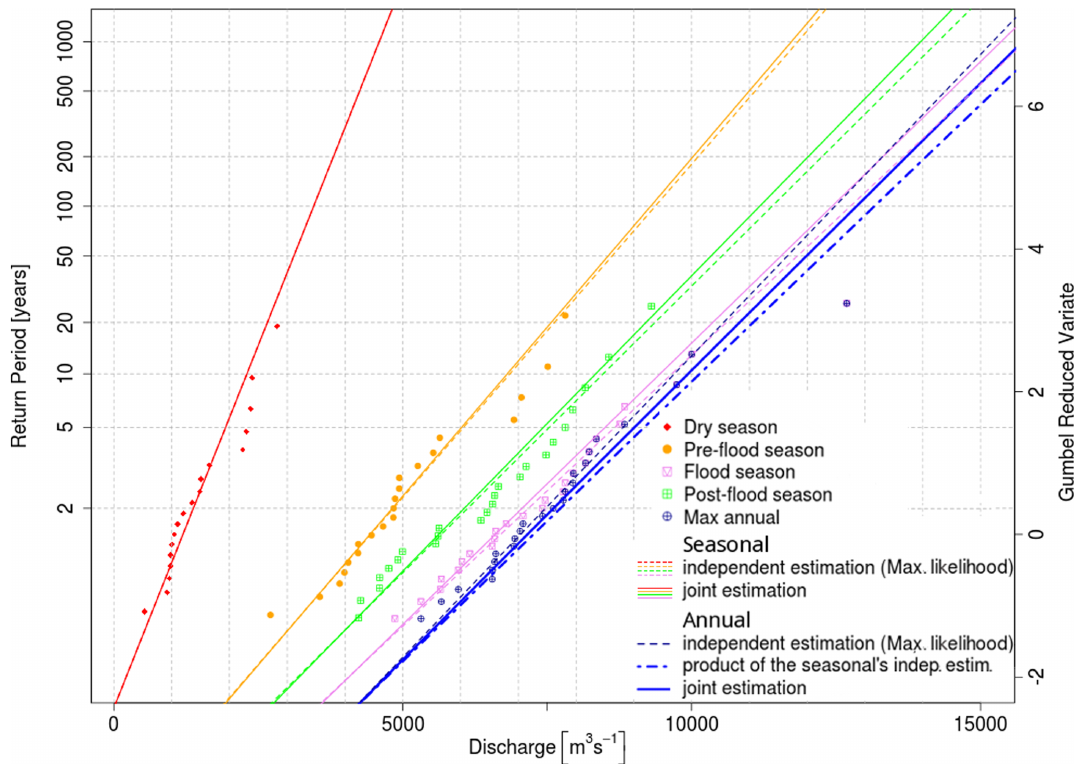
Fig. 3. Empirical CDFs (dots) and maximum likelihood estimates (dotted lines), blue refers to annual maxima; annual maximum CDF obtained as the product of the seasonal CDFs estimated through the method of maximum likelihood (blue dash-dotted lines); seasonal CDFs jointly estimated by maximizing Eq. (2) (thin lines) and annual flood CDF obtained as the product of the jointly estimated seasonal CDFs (thick blue